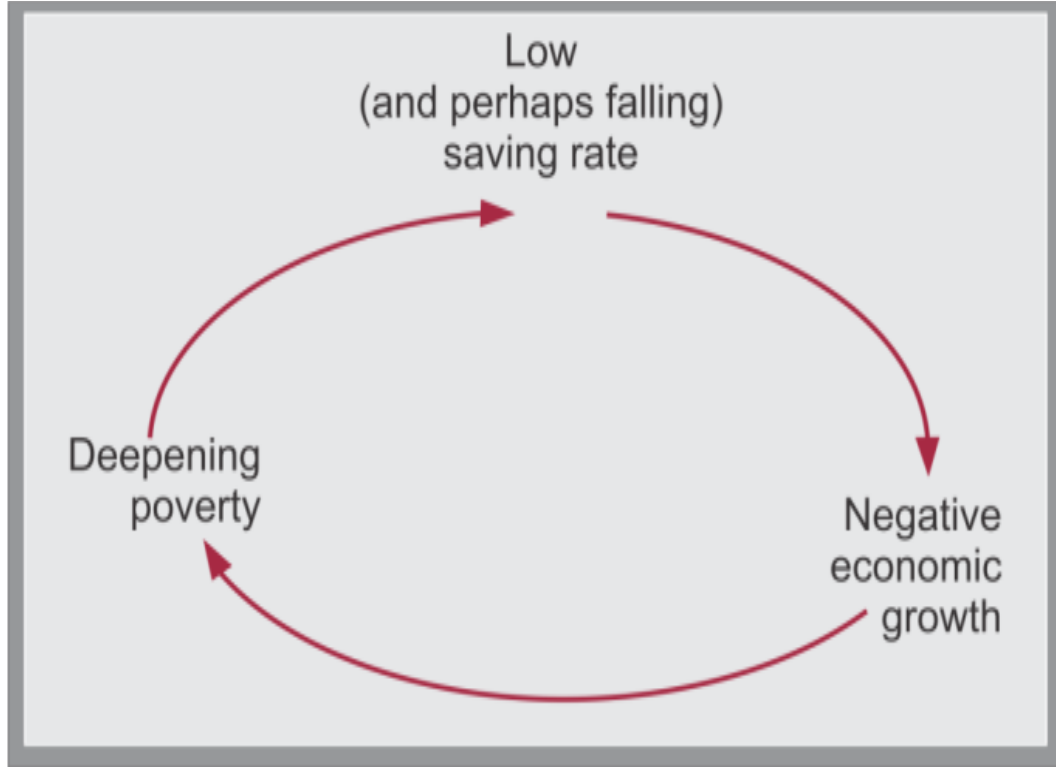
Figure 4: The poverty trap entrenching a cycle of underdevelopment. Source: Sachs